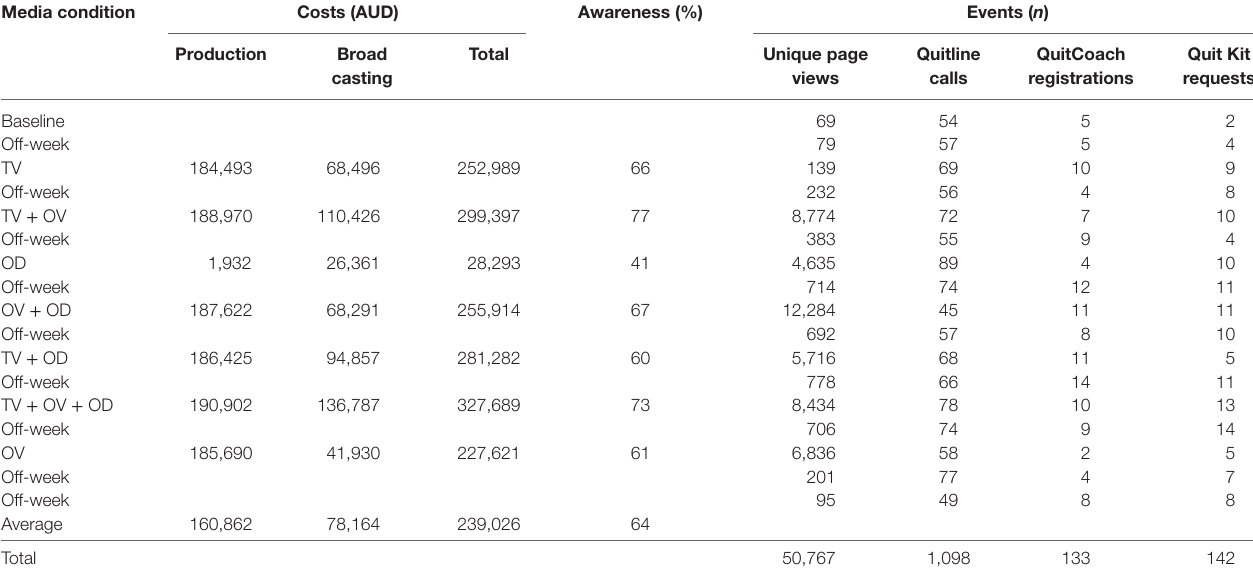
taBlE 2 | Campaign costs, awareness, and events by media condition.